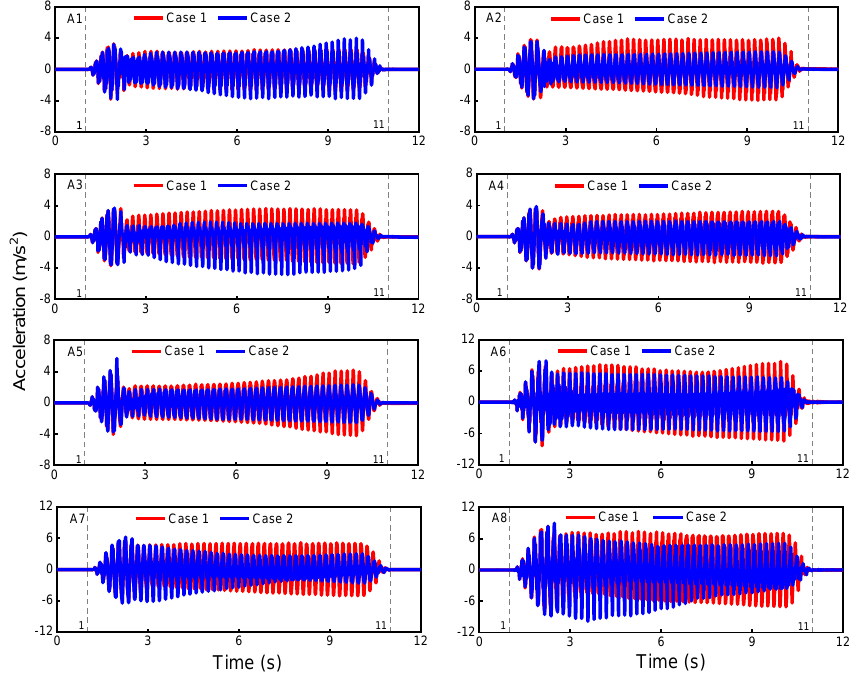
Figure 8. Time-history curves of the acceleration (when PGA = 0.20 g).